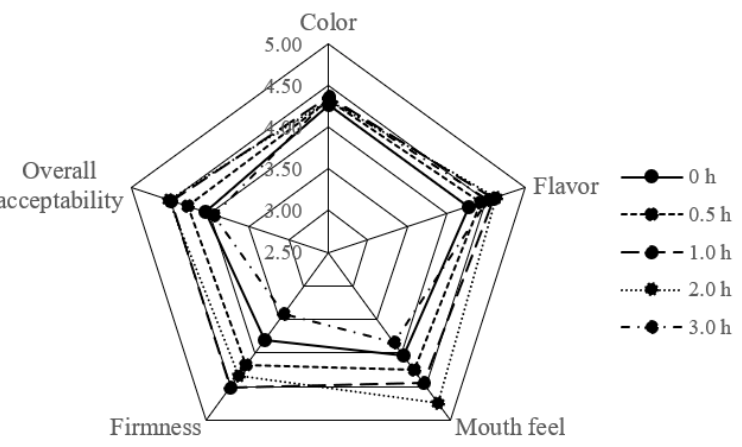
Figure 3. Sensory evaluation of tofu prepared from soymilk with different TGase pre-crosslinking times (0, 0.5, 1, 2 and 3 h) and then coagulated by GDL.